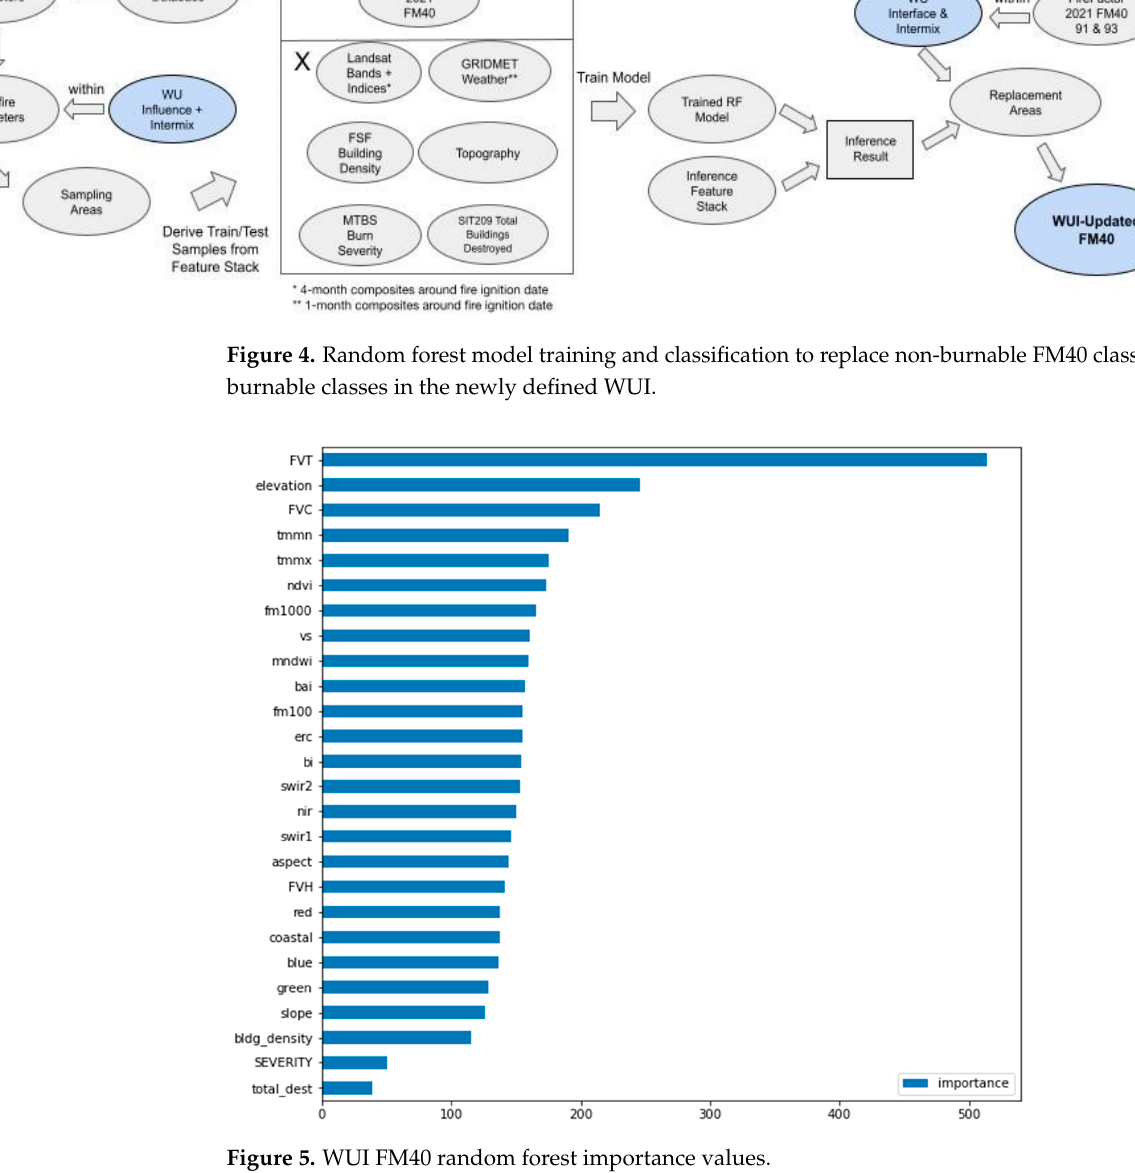
Figure 5. WUI FM40 random forest importance values.